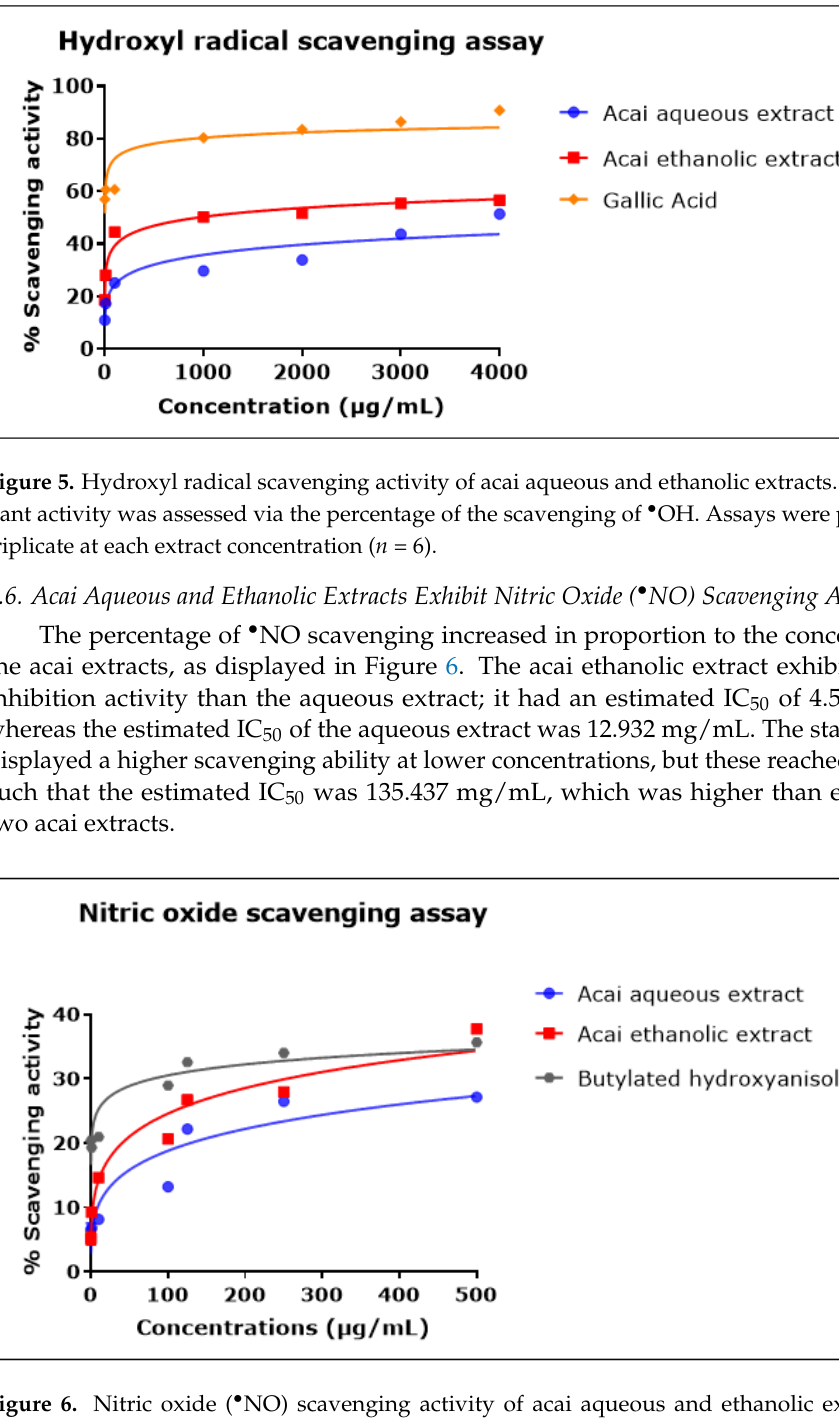
Figure 6. Nitric oxide ( • NO) scavenging activity of acai aqueous and ethanolic extracts. Acai antiox-